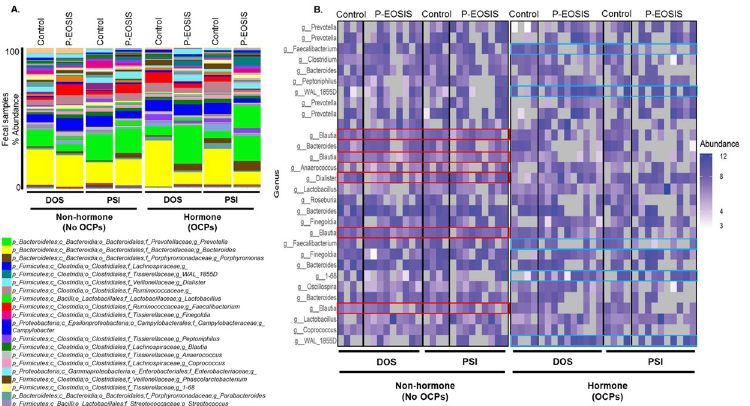
Fig 4. Relative abundance of GI microbial dynamics in control subjects and patients with endometriosis (P-EOSIS). Subjects were either not receiving hormonal therapy (OCPs) (control = 4; P-EOSIS = 9) or receiving OCPs (control = 4; P-EOSIS = 10). A . Level 6 (genera) taxonomical summary plots for fecal samples. Samples were collected from subjects at the time of surgery (DOS) (left panel) and following surgical intervention (PSI) (right panel). B . The top 30 abundant bacterial genera in the GI tract of control and P-EOSIS.